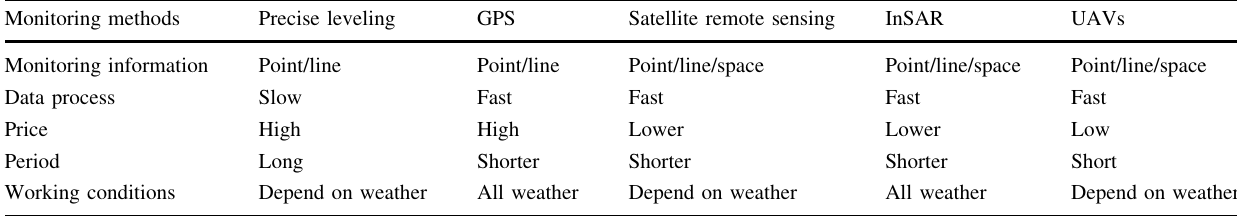
Table 1 Comparison between UAVs and other monitoring methods in MA Monitoring